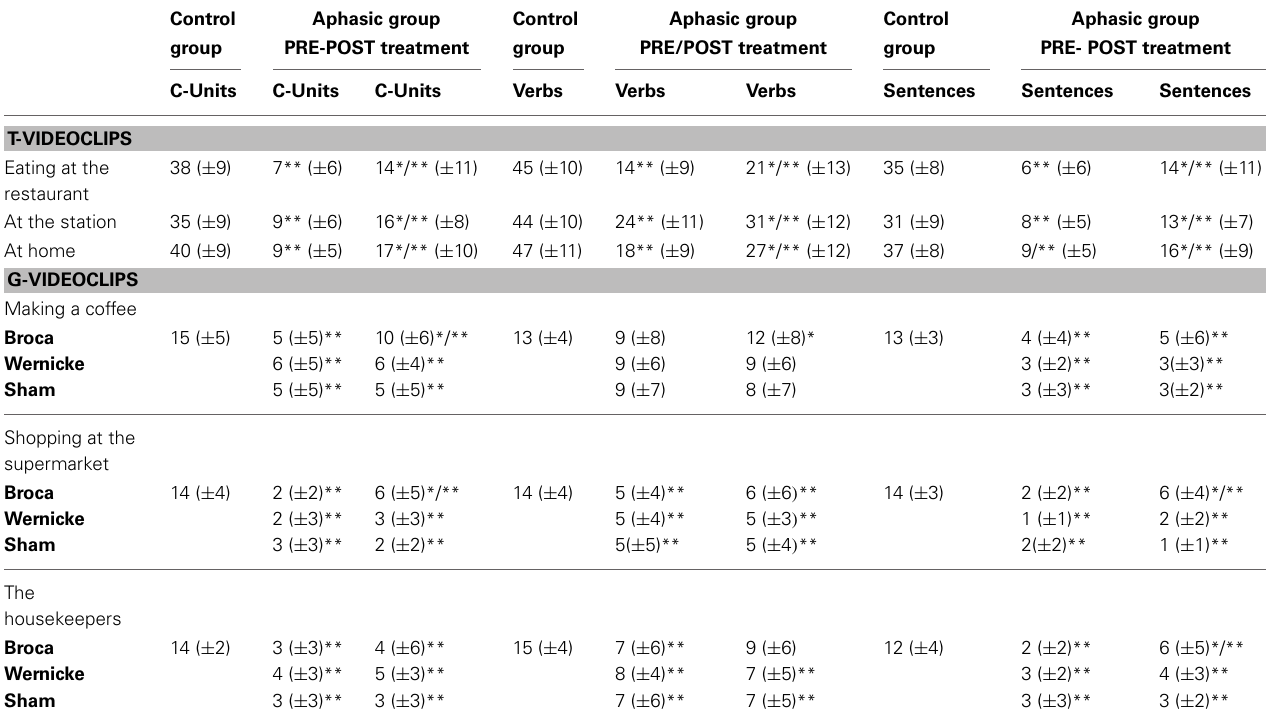
Table 2 | Mean number ( ± Standard Deviation) of C Units, Verbs, Sentences for the control and aphasic group collected in each T- and